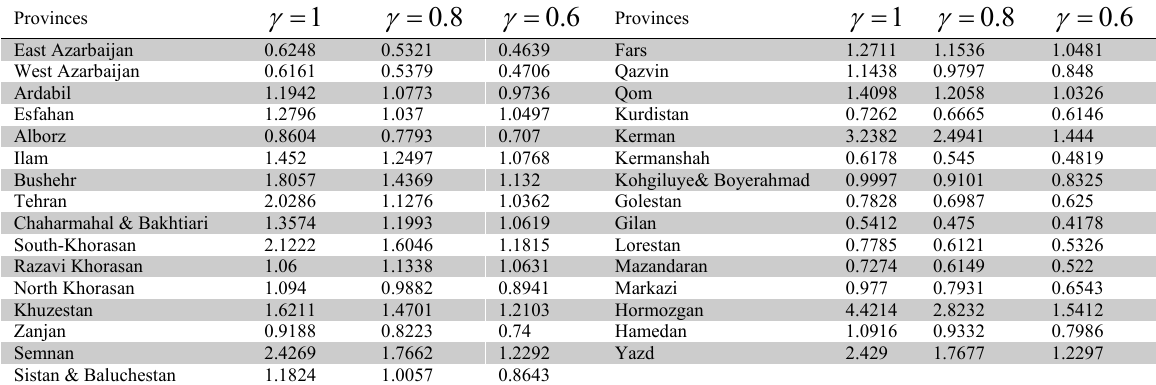
The results of CreDEA-RS model